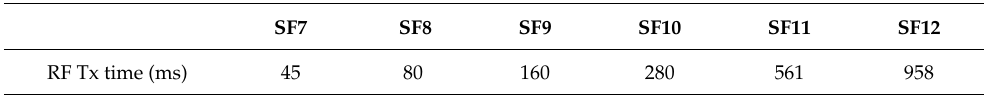
Figure 13. Experimental field (45 ◦ 42 (cid:48) 25.99 (cid:48)(cid:48) N, 3 ◦ 00 (cid:48) 40.54 (cid:48)(cid:48) E, 433 m) and a sensor node buried at 15 cm deep. Once the sensor node is installed, some soil is added and compacted by foot. To transmit the data frame of 25 bytes presented in Table 1, the time on air in LoRa varies from 45 ms to 958 ms with respect to the value of the spreading factor (SF), see Table 2. We selected the lowest value (SF = 7) to reduce the time on the air at its minimal value and therefore limit the energy consumption of the buried sensor node. The LoRa module on the collector node was tuned on the same SF. A low value of SF leads also to a reduced communication range but that is not issued as the UAV can come close to the buried sensor node. For these tests, the transmit power was maintained at +14 dBm/25 mW, which is the maximal allowed transmit power in Europe in the 868 MHz frequency band. Table 2. RF transmit time of a data frame of 25 bytes with respect to SF (BW = 125 KHz, CR = 4/5). Values obtained from Semtech’s datasheets [40].